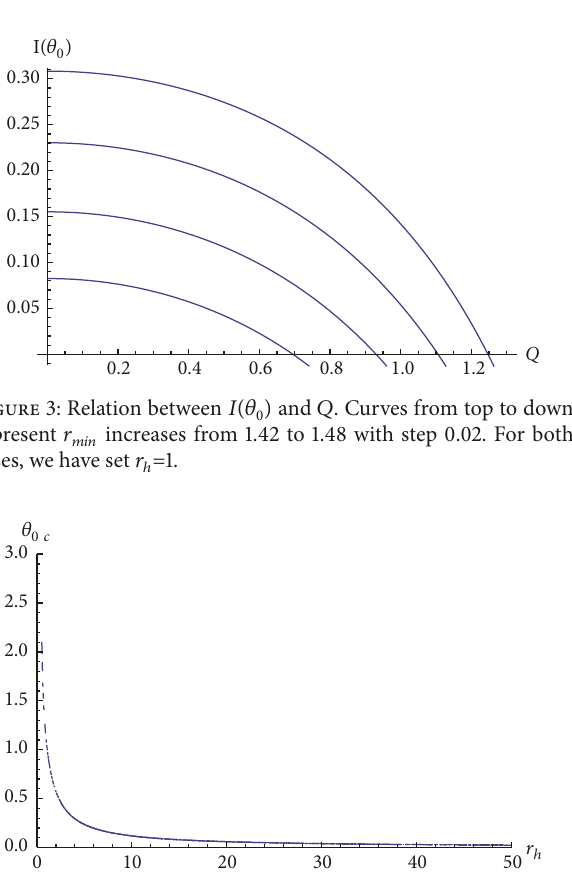
𝜃 𝑟 0𝑐 decreases as ℎ